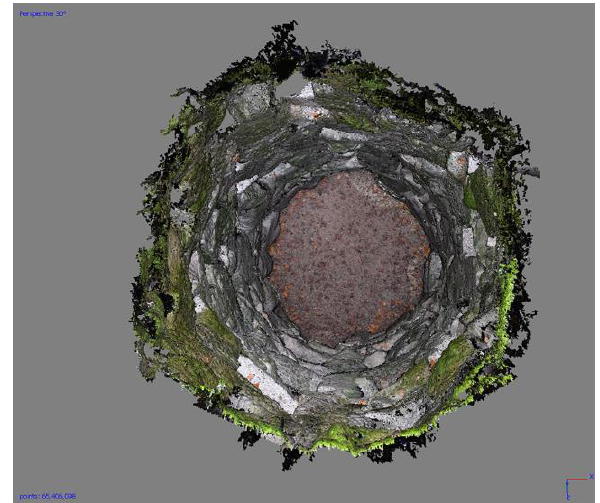
Figure 8 . The Quinta da Regaleira in Sintra, the Poço Imperfeito , point cloud created by drone